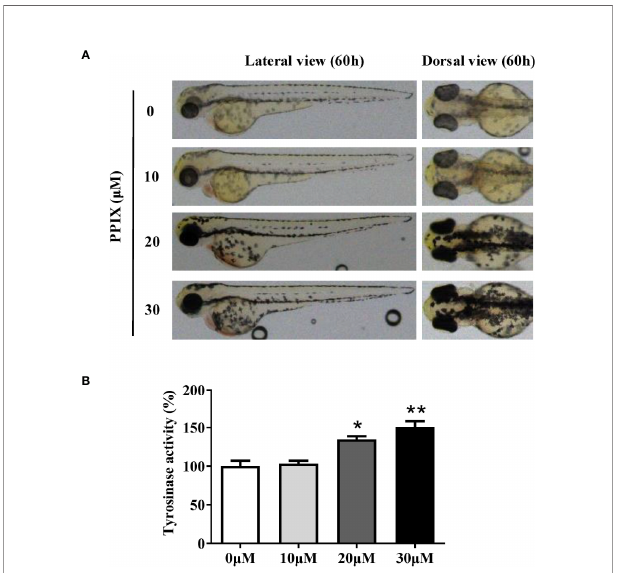
FIGURE 6 | Effect of PPIX on pigmentation in zebra fi sh. (A) Representative photographs of zebra fi sh. Zebra fi sh embryos were treated with PPIX from 35 to 60 h. The effects on the pigmentation of zebra fi sh were observed under the stereomicroscope. (B) Tyrosinase activity. For measurement of tyrosinase activity, 100 m g of total protein was incubated with L-DOPA ( fi nal, 0.5 mM) and then quanti fi ed using a spectrometer. The results were shown as relative values to the control. Data are expressed as the mean ± SEM (n = 3). *p < 0.05, **p < 0.01 versus non-treated zebra fi sh.